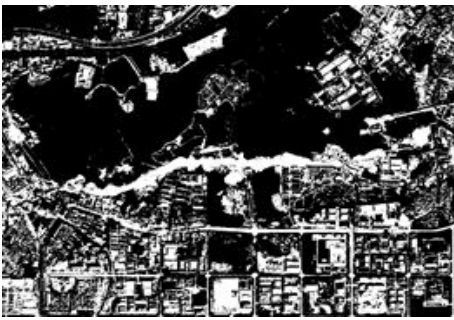
Figure 2. Iterative threshold segmentation